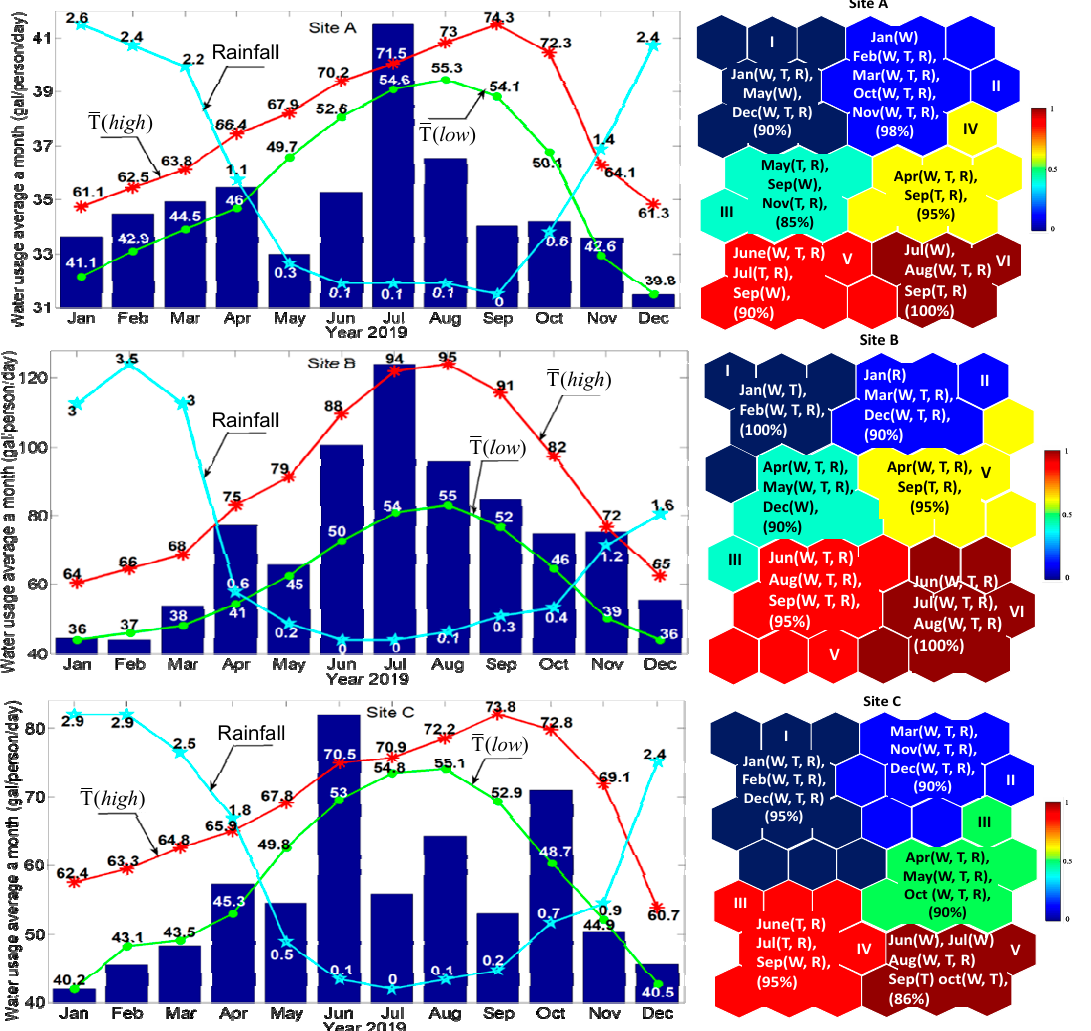
Figure 5. ( Left ) Monthly average daily per person water use and monthly average low, T ( low ) , and high, T ( high ) , temperatures ( ◦ F) and rainfall (inches) profiles in 2019 for the three study sites. ( Right ) SOM representation of the correlation among water usage and {temperature, rainfall} on monthly scale. Temperature and rainfall are correlated at monthly scale with {June, July, August, and September} being of higher temperature and lower rainfall, respectively. Higher water use (gallons/person/day) is correlated with higher temperature and low rainfall (red clusters at the bottom) as visualized in the clusters of high ranges (red) along with the influenced factor (lower rainfall values). The W, T, and R in the right figure refer to water use, temperature, and rainfall.